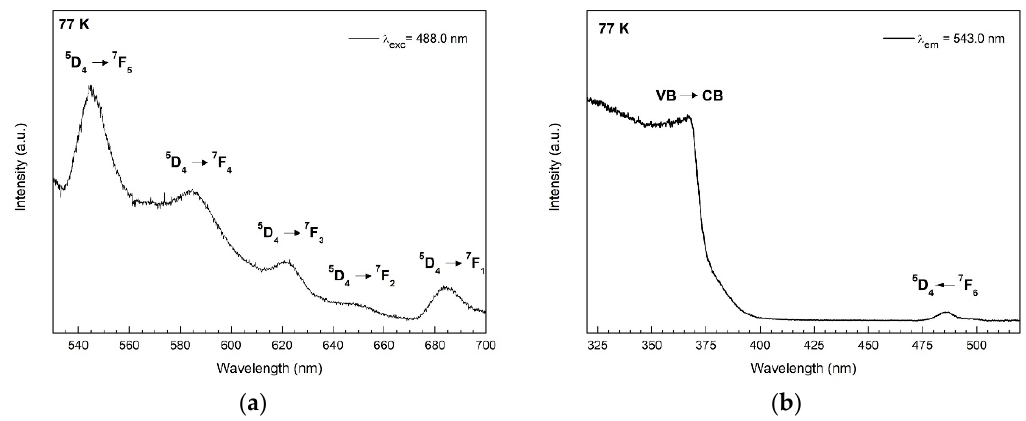
Figure 10. Emission ( a ) and excitation ( b ) spectrum of Tb 3+ ions in ZnO:Tb at 77 K.